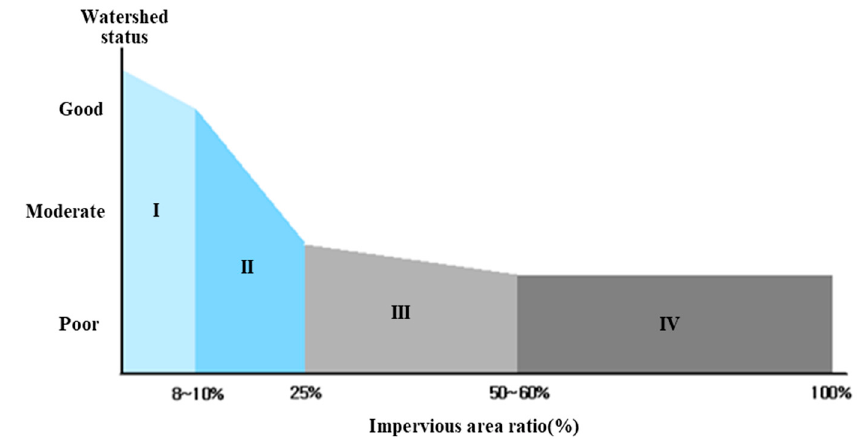
Figure 4. Water quality of the watershed by impervious area.